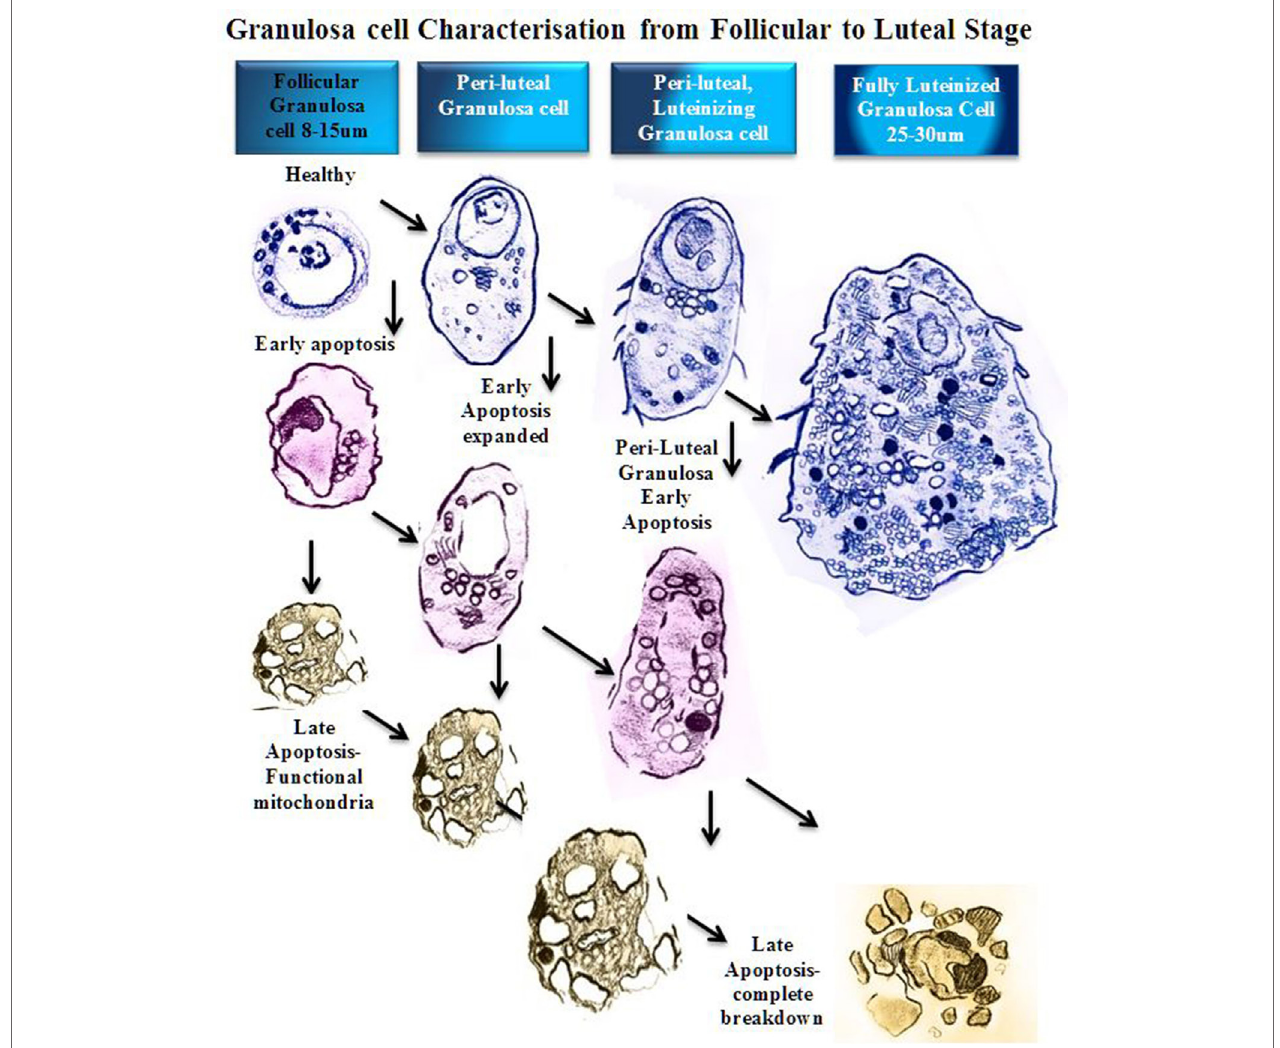
FiGURe 2 | Schematic diagram of granulosa cell characterization from follicular to luteal phase. In a stage-dependent progression, the granulosa differentiates from a compact 8–15 µm cell with a large round nucleus and relatively small cytoplasm (12). The cytoplasm contains mitochondria, rough endoplasmic reticulum, Golgi apparatus, lipid droplets, and many other organelles (14). As the granulosa cell matures, the organelles proliferate and the cytoplasm expands to accommodate new steroidogenic capacity. A fully luteinized granulosa cell, 25–30 µm, contains a large volume of mitochondria, steroid filled lipid droplets, and smooth/rough endoplasmic reticulum, and has the capacity to produce progesterone directly (8). At any stage of follicular growth the granulosa cell can undergo apoptosis. Early apoptosis is characterized by collapse of the cell membranes and condensation of the chromatin, which often polarizes in the nucleus with the organelles clustered adjacent (15). Early apoptosis in a granulosa cell with an expanded cytoplasm is similarly changed with a greater volume of organelles clustered around a collapsing nucleus. Late stages of apoptosis end with compartmentalization of organelles into blebs and extrusion of apoptotic bodies that may contain nucleic